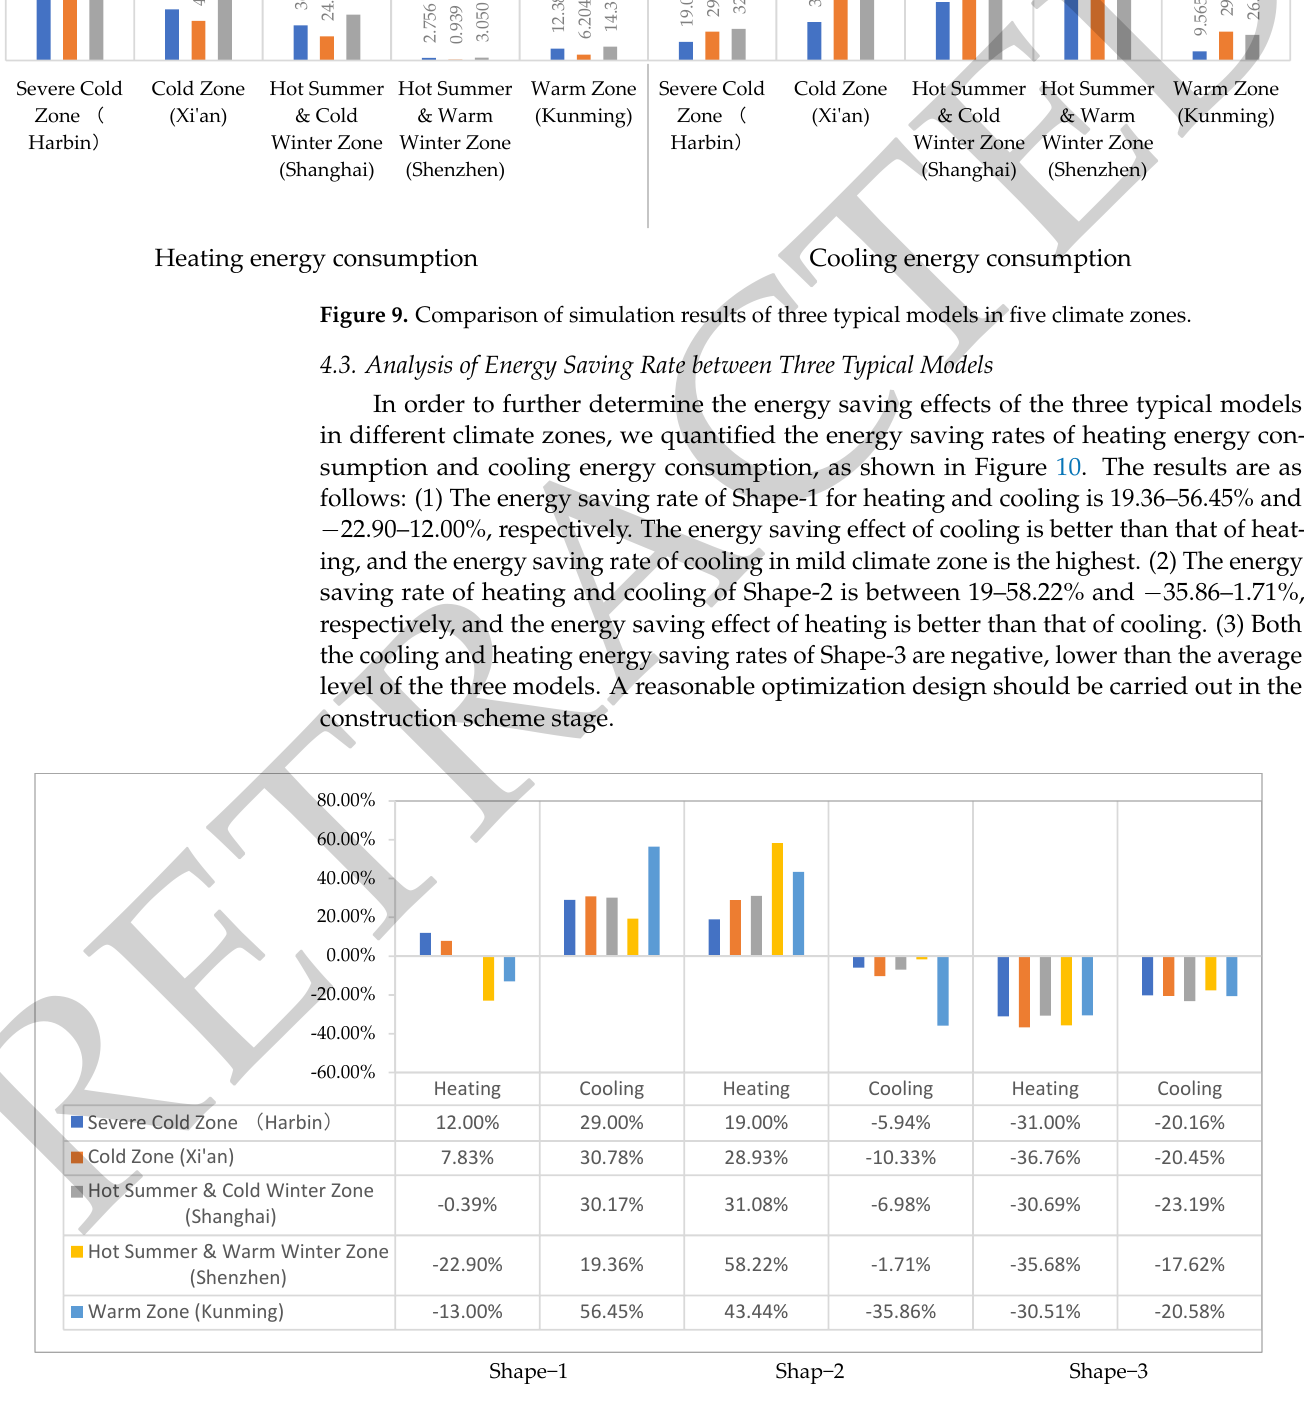
Figure 10. Energy saving rate of three models in five climate zones.